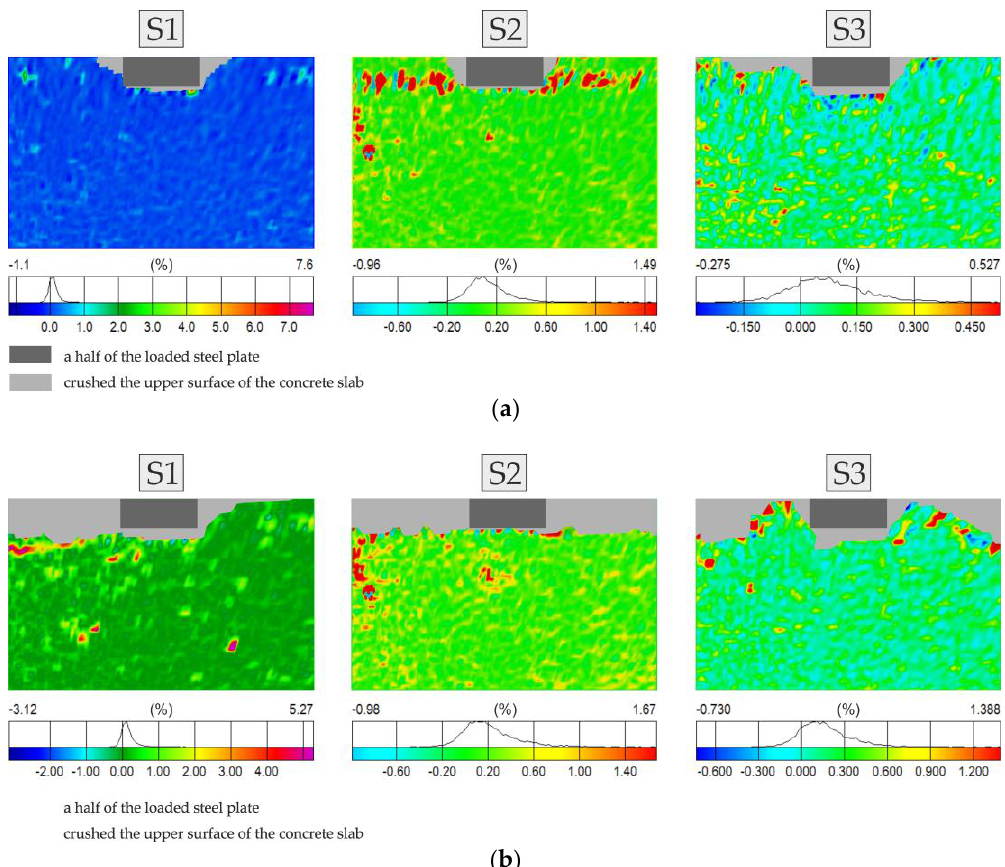
Figure 11. Strains at slab upper surface: ( a ) at peak load; ( b ) at last load.